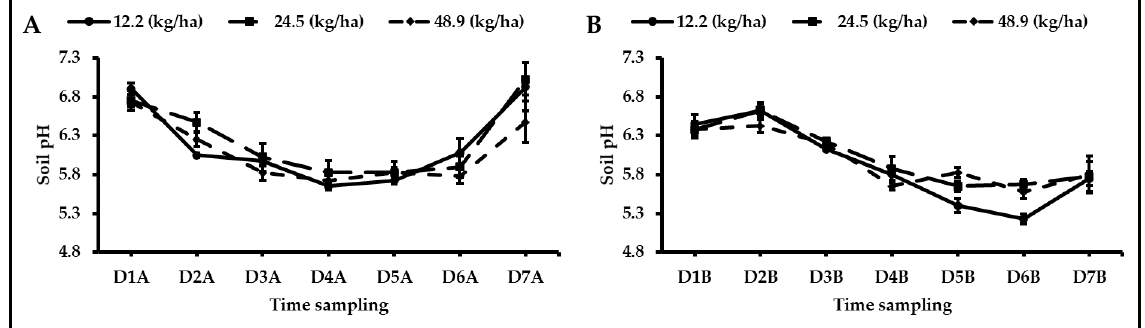
Figure 4. Soil pH of two farms (Farm ( A ); Farm ( B )) with different P fertilizer application rates (12.2 kg P ha −1 ; 24.5 kg P ha −1 ; and 48.9 kg P ha −1 ) in the year 2019. Each D represents a date: D1A = 21 December 2018; D2A = 30 January 2019; D3A = 13 February 2019; D4A = 27 February 2019; D5A = 13 March 2019; D6A = 27 March 2019; D7A = 25 April 2019; D1B = 6 December 2018; D2B = 28 January 2019; D3B = 11 February 2019; D4B = 25 February 2019; D5B = 11 March 2019; D6B = 25 March 2019; and D7B = 22 April 2019. Error bars exhibit the standard error of the mean from four replicates of the measurements.